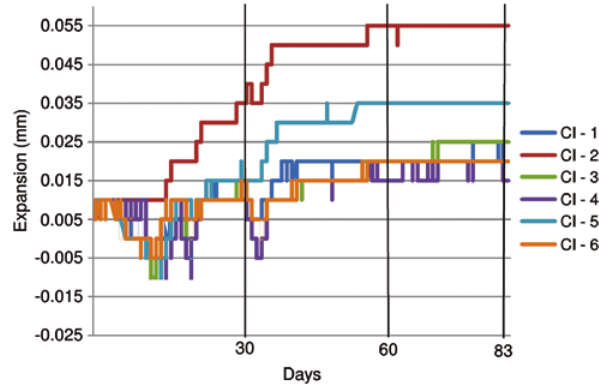
Figure 10 The apparatus for the measurement of expansion of hardened concrete according to ASTM C490-86 placed in a climatic chamber.